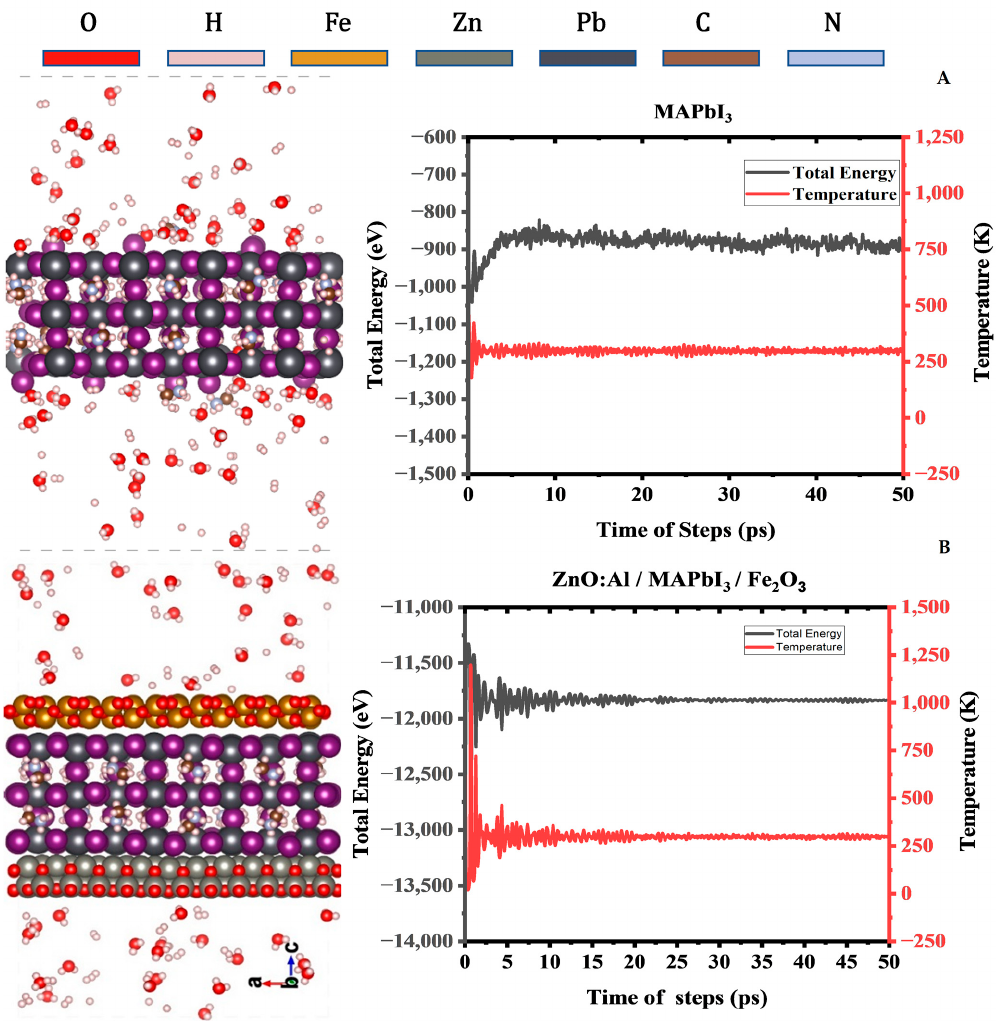
Figure 6 . The fluctuations of energy and temperature for ( A ) MAPbI 3 (001) surface in a solution of H 2 O, OH-, H 3 O+, and H+ molecules, and ( B ) ZnO/MAPbI 3 /Fe 2 O 3 heterostructure. Snapshots were taken at 50 ps from AIMD simulations at 300 K.